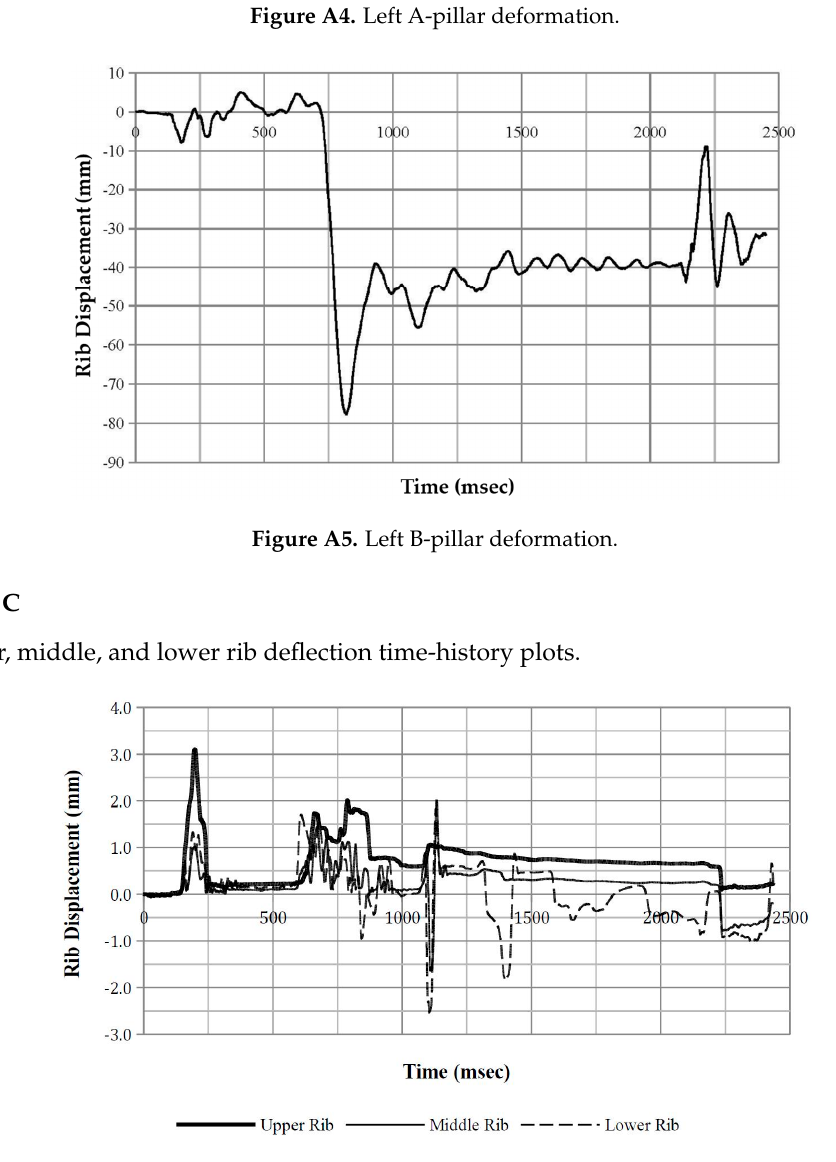
Figure A6. ATD Position 1 rib displacement.